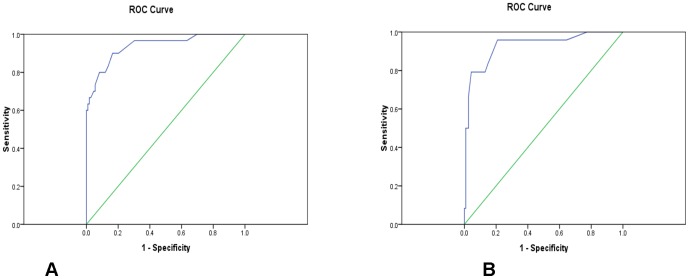
Figure 4A: ROC curve for IBS vs. controls. Figure 4B: ROC curve for cross-validation.